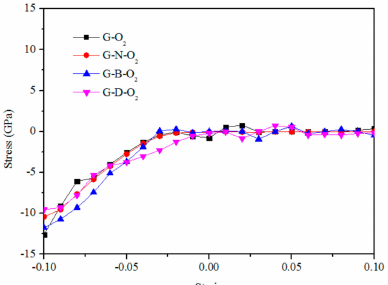
Figure 4. Young’s modulus as a function of equibiaxial strain for G–O 2 , G–N–O 2 , G–B–O 2 , and G–D–O 2